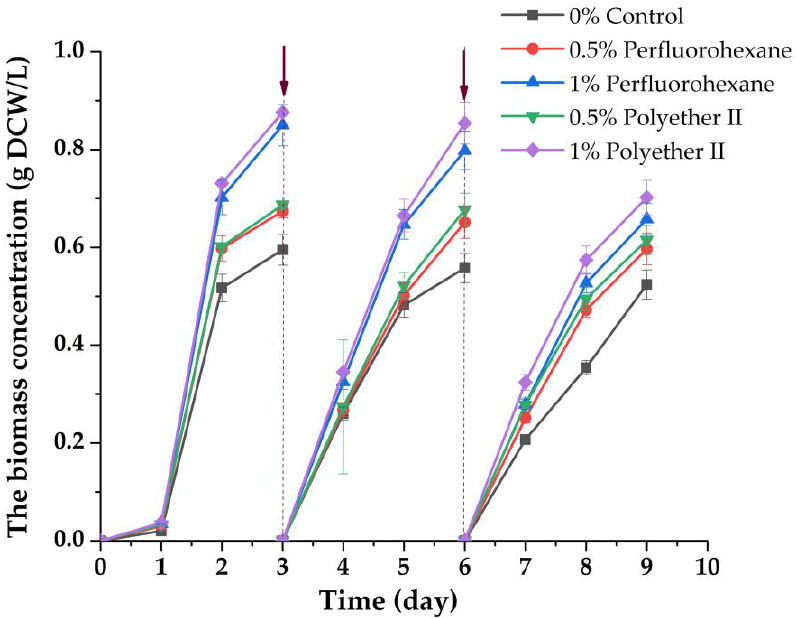
Figure 3. Changes in the concentration of C. vulgaris suspended biomass during its accumulation in wastewater with or without addition of PFCs, using an immobilized inoculum. The arrows indicate the time of the following procedure: draining of the liquid medium with suspended biomass; separating biomass of free microalgae cells; adding 1 g/L glycerol to the waste medium; returning of the culture liquid medium to the photobioreactor with the immobilized inoculum.